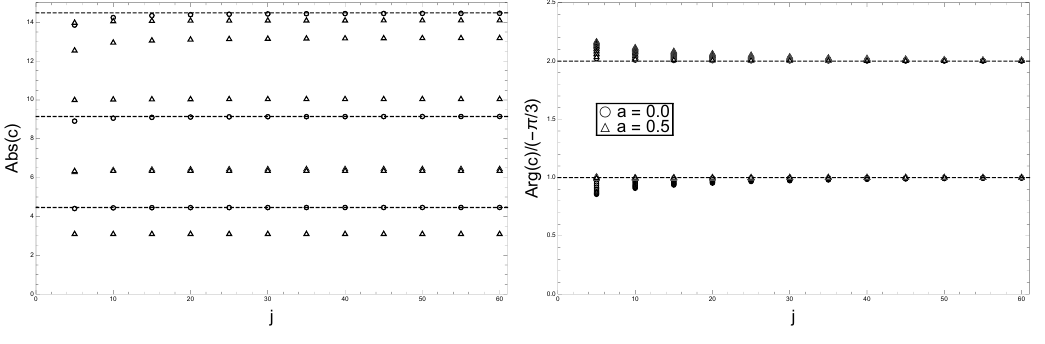
Figure 3 . Large j (eikonal limit) analysis. Shown here are the quantities Abs( c ) and (cid:16)(cid:16) (cid:17) (cid:16) (cid:16) (cid:17)(cid:17)(cid:17) (cid:23) (cid:23) Arg( c ) = ( (cid:0) (cid:25)= 3), where c := (cid:0) sign Re (2 j ) 4 = 3 , derived from the QNMs of h ++ af- j j ter the limit eq. (3.1). The dashed lines are the expected values according to [88, 89]. For large j , the values at a = 0 (circles) and a = 0 : 5 (triangles) in the right plot converge to the predicted ones. In the left plot, the same is true for the case a = 0 (circles). At a 6 = 0 (triangles), however, we discover a new feature. The large j values shift depending on a